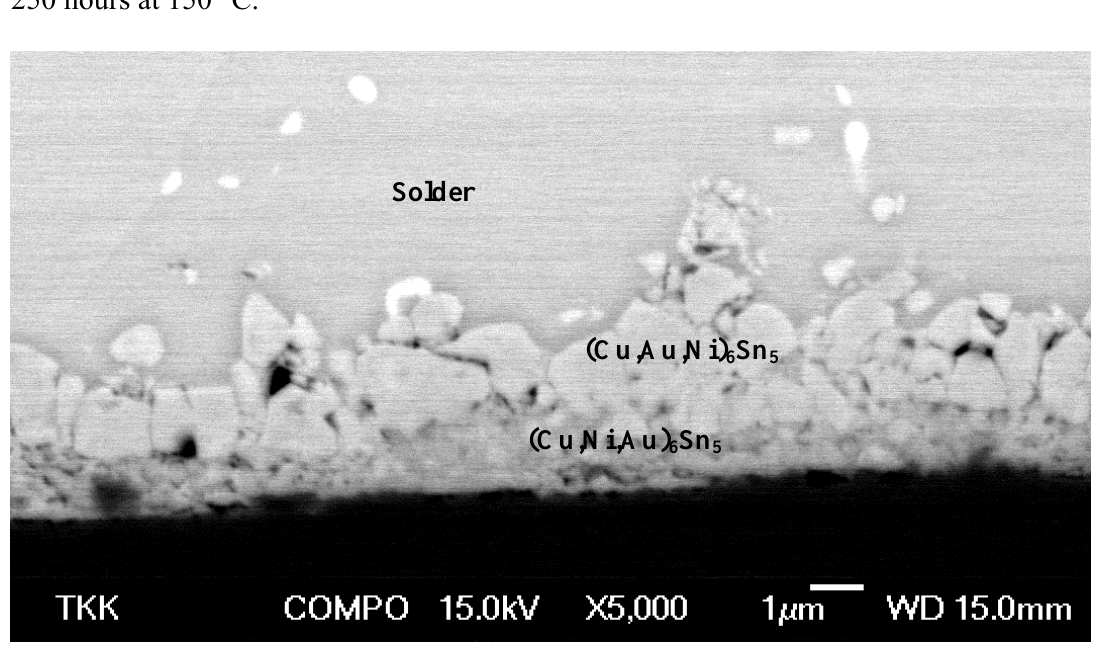
Figure 20. SEM micrograph from the (SnAgCu)/Ni/Au system after annealing for 250 hours at 150